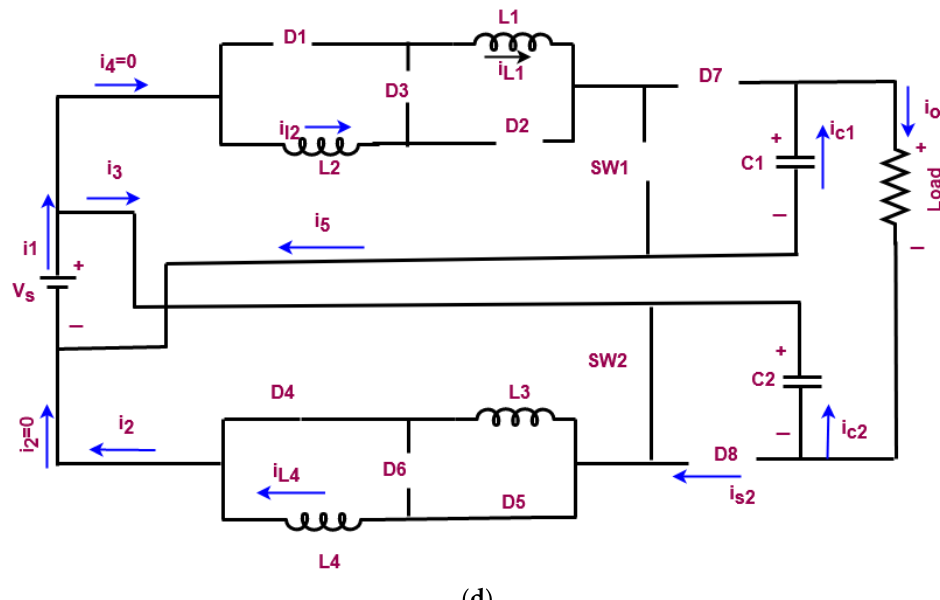
Figure 5. Mode of operations ( a ). Mode 1 ( b ). Mode 2 ( c ). Mode 3, and ( d ). Mode 4.